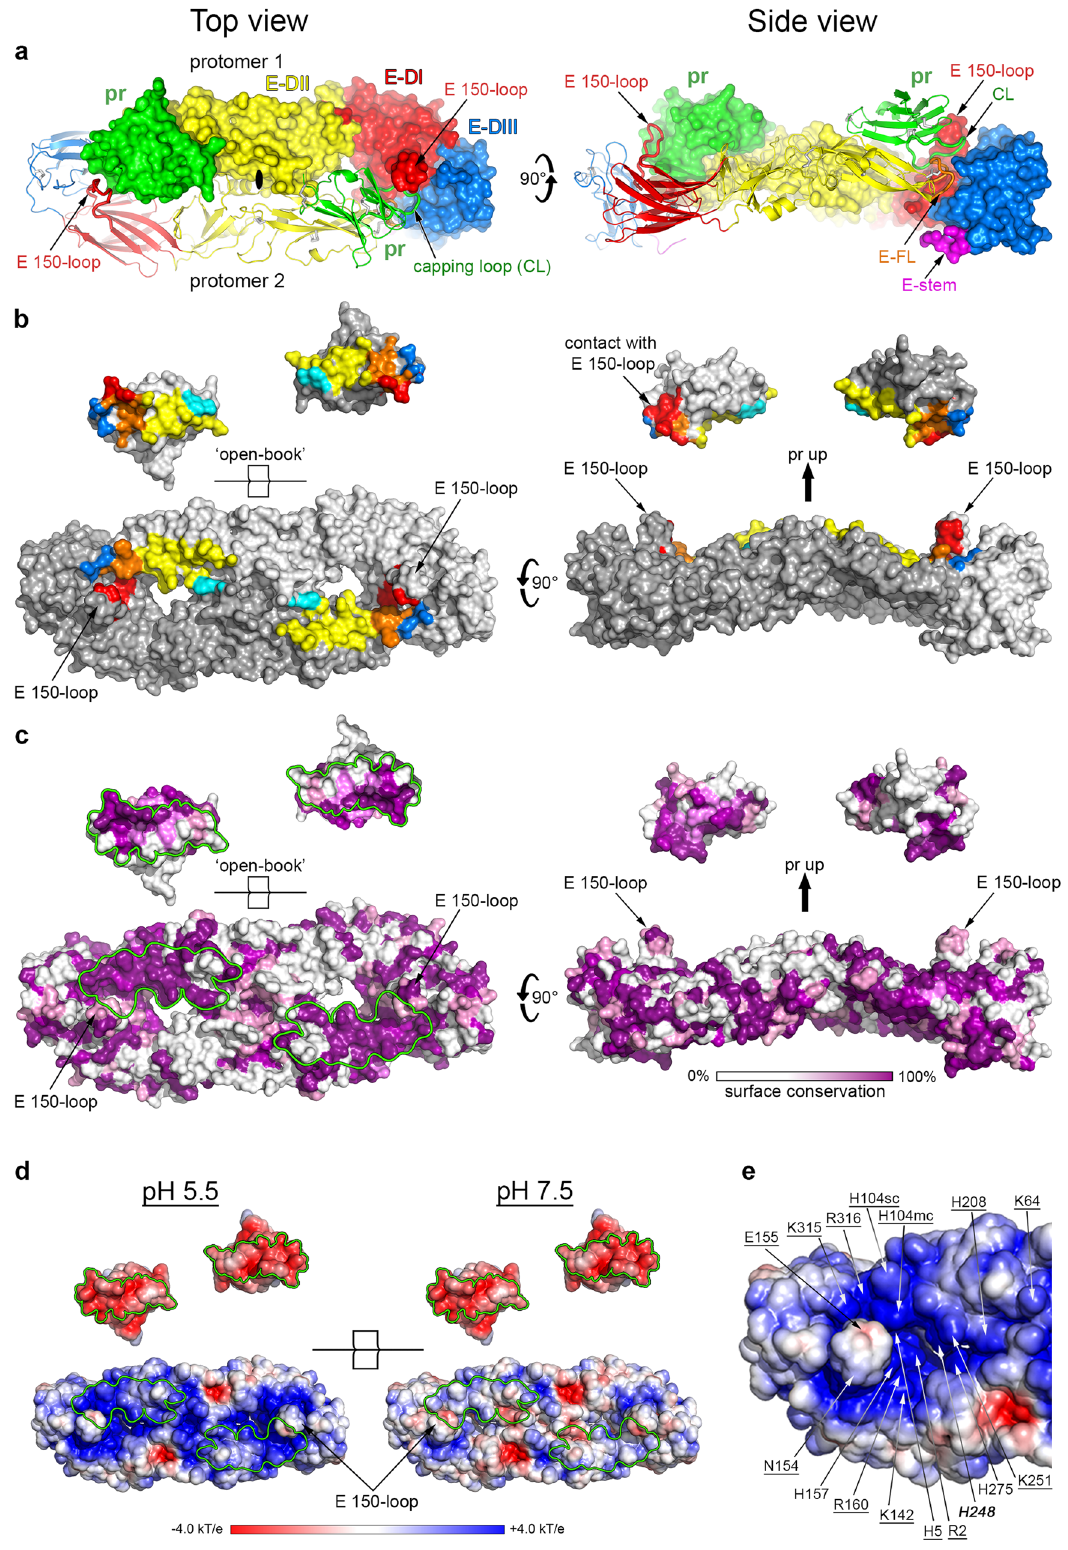
substrate binding domain (SBD) of type I and II HSP40/DnaJ protein cofactors (or chaperonins) of the heat shock protein 70 (HSP70) cellular chaperone system 32 . In the HSP40 molecules, the SBD is composed of two related consecutive β -sandwich sub- domains termed “ substrate binding motifs 1 and 2 ” (SBM-1 and